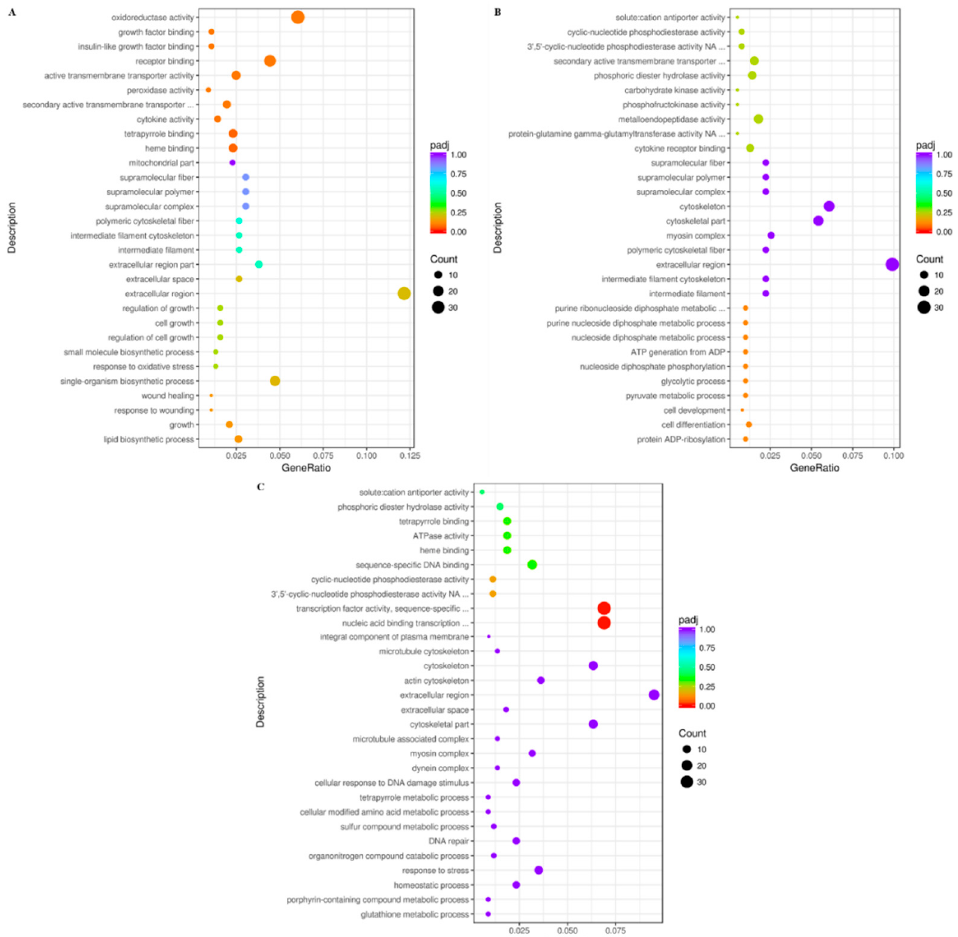
Figure 2. GO function classification of the differentially expressed genes (DEGs) comparison between the groups (padj < 0.05). ( A ) hypoxia1h_vs_normoxia, ( B ) hypoxia4h_vs_normoxia, ( C ) reoxygen4h_vs_normoxia. The x -axis represents the number of genes and the y -axis represents different Gene Ontology (GO) term functional classification.